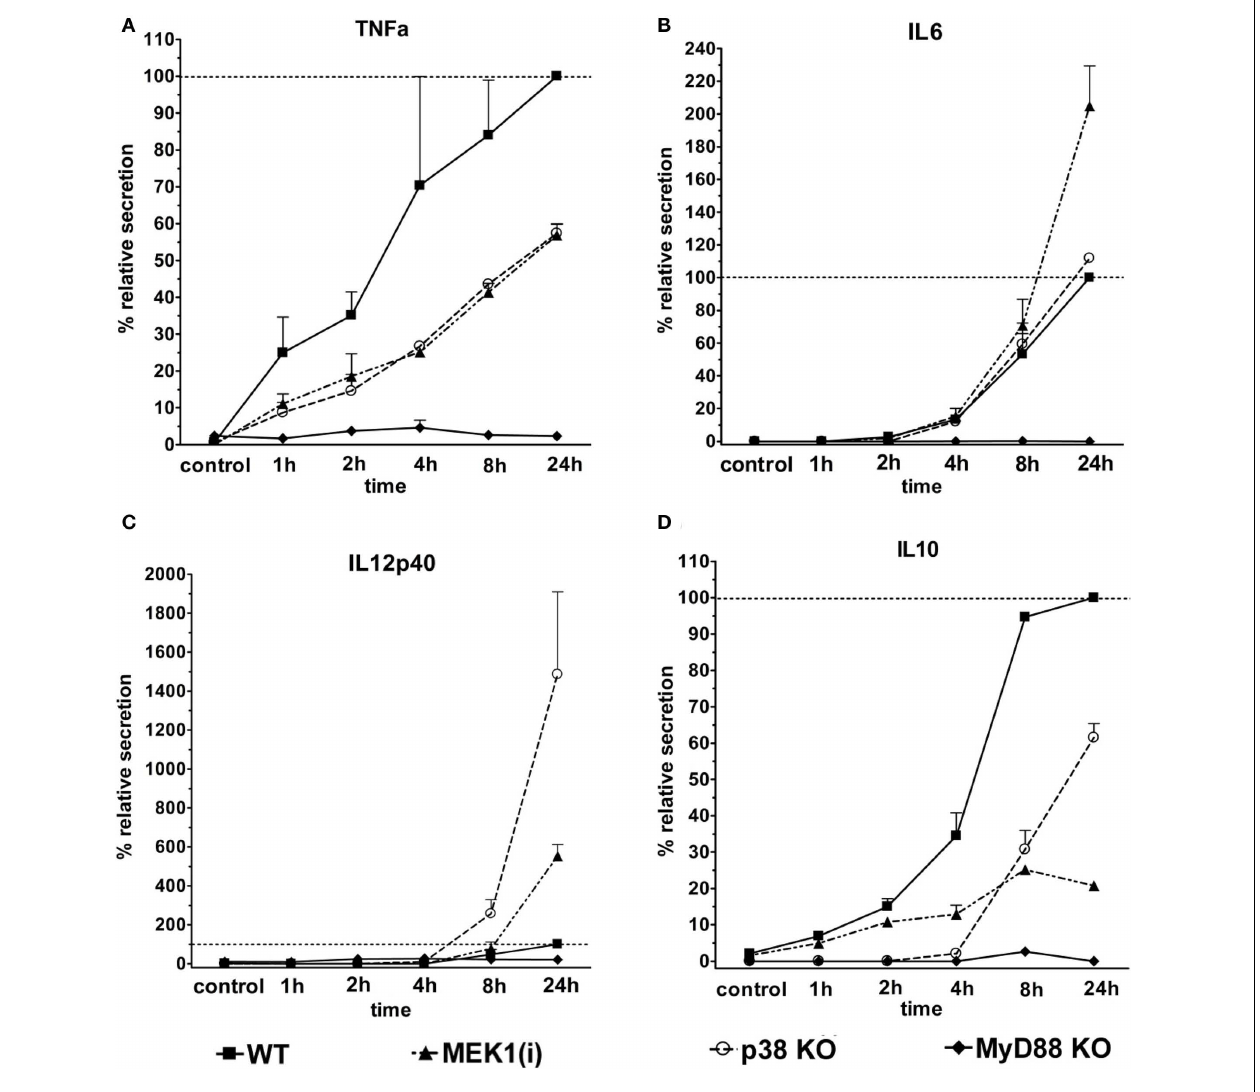
differences between experiments in the absolute amount of cytokines produced, the maximum level of the LPS-treatedWT or control macrophage was set to 100% (shown as —–). Shown are mean + SD values from two independent